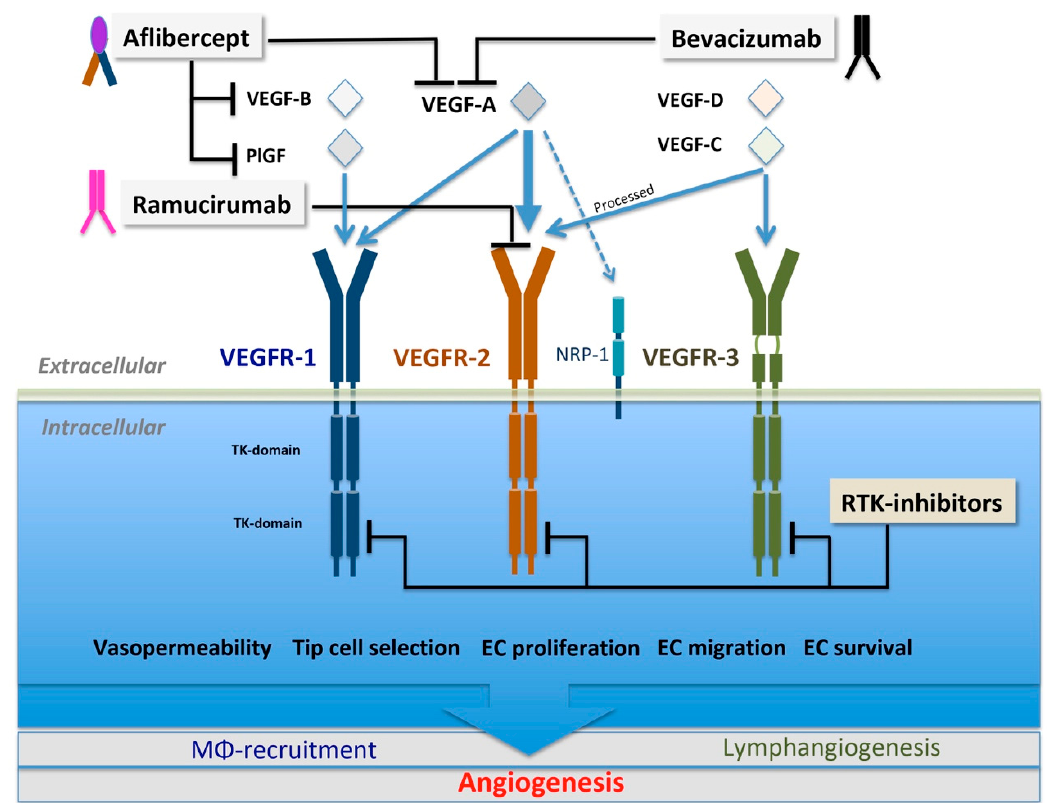
Figure 2. The VEGF/VEGFR signaling axis, its contribution to neoangiogenesis and treatment modalities interfering with its activity. Binding of VEGF ligands to their cognate receptors leads to receptor dimerization and autophosphorylation triggering a down-stream intracellular phosphorylation cascade. In principle, tumor anti-angiogenesis can be achieved (1) by prohibiting ligand binding to their cognate TK receptors (VEGFR1-3) receptors/non-tyrosine kinase (NRPs) co-receptors either by the withdrawal of pro-angiogenic ligands of the VEGF family (Aflibercept, Bevacizumab) or by blocking the accessibility of the binding pocket for ligands on a particular receptor (Ramucirumab); (2) by interfering with the kinase activity of VEGFRs (small molecule multikinase inhibitors: receptor tyrosine kinase (RTK)-inhibitors). Anti-VEGF-targeted therapies result in the inhibition of down-stream signaling mechanisms, governing a range of steps involved in neovessel formation and/or inflammatory infiltration. Abbreviations: EC, endothelial cell; M Φ , macrophage; PlGF, placental growth factor; RTK, receptor tyrosine kinase; TK-domain, tyrosine kinase-domain; VEGF, vascular endothelial growth factor; VEGFR, vascular endothelial growth factor receptor.